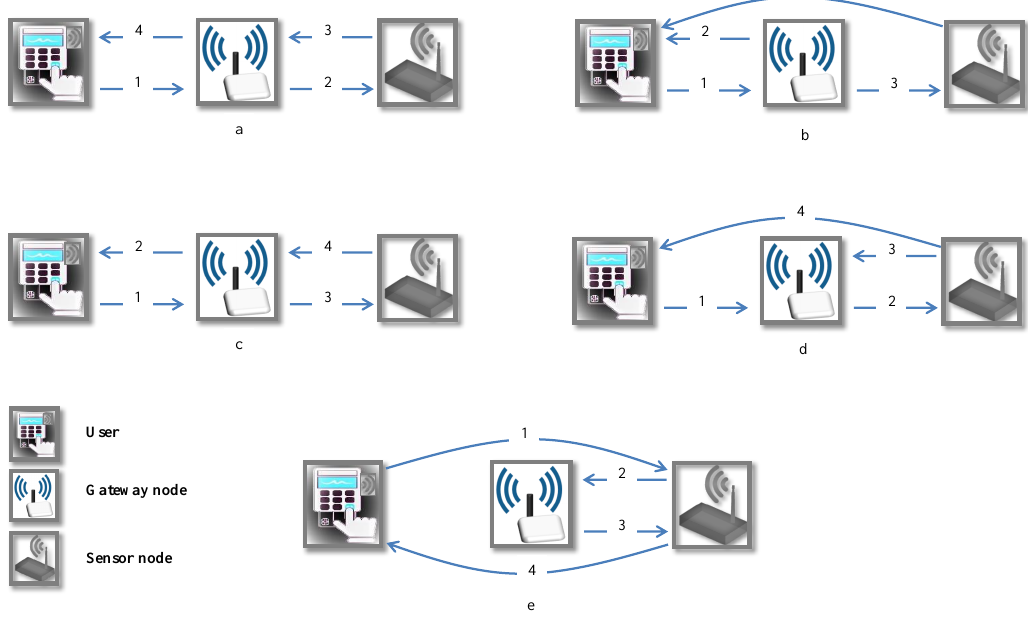
Figure 1. Five user authentication models in HWSN